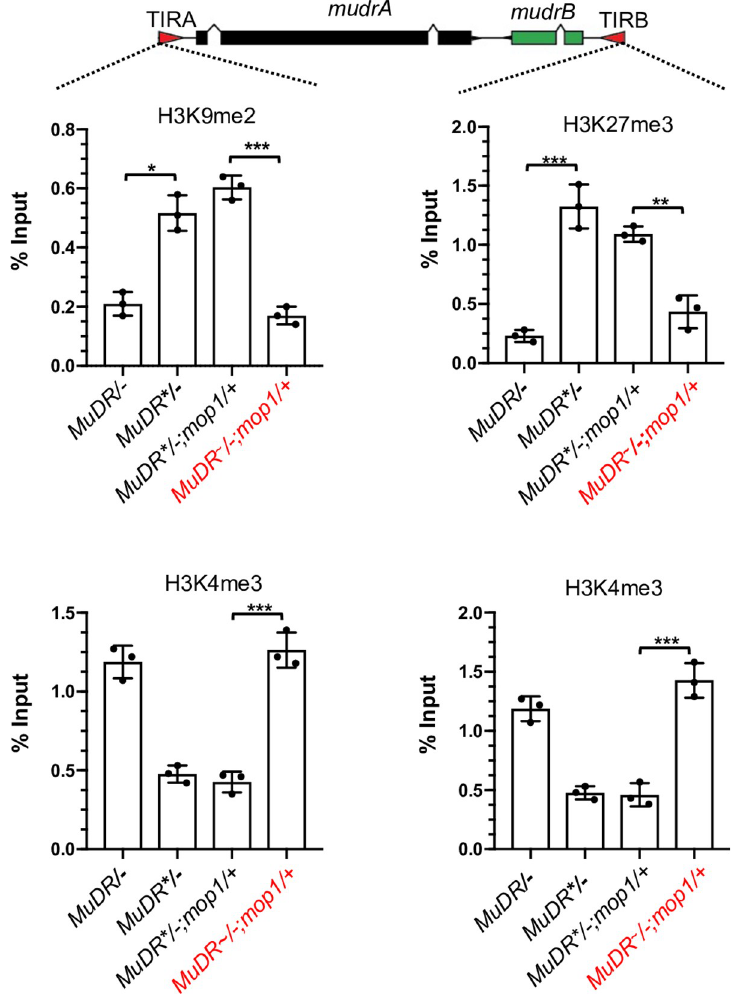
Fig 8. ChIP-qPCR analysis of enrichment of histone marks, H3K9me2, H3K27me3 and H3K4me3 at TIRA and TIRB. Relative enrichment of H3K9me2, H3K27me3 and H3K4me3 at TIRA and TIRB in leaf 3 of plants of the indicated genotypes. qPCR signals were normalized to Copia and then to the value of input samples. Red text indicates plants derived from heat-treated plants. MuDR � refers to a silenced MuDR element. MuDR ~ refers to a reactivated element. An unpaired t-test was performed. Error bars indicate mean ± standard deviation (SD) of the three biological replicates. � P < 0.05; �� P < 0.01; ��� P < 0.001.